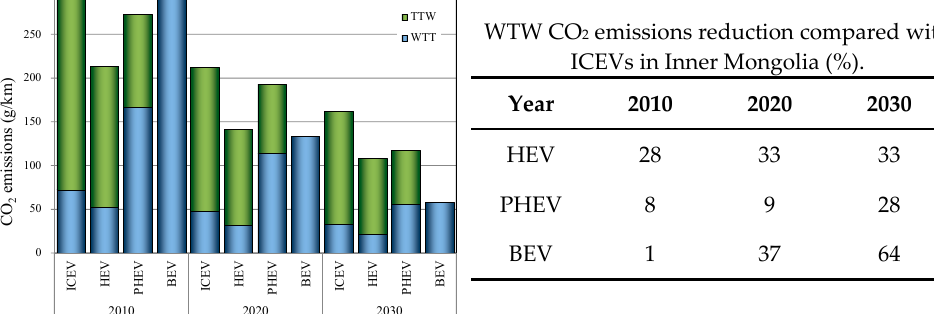
WTW CO 2 emissions reduction compared with ICEVs in Inner Mongolia (%).